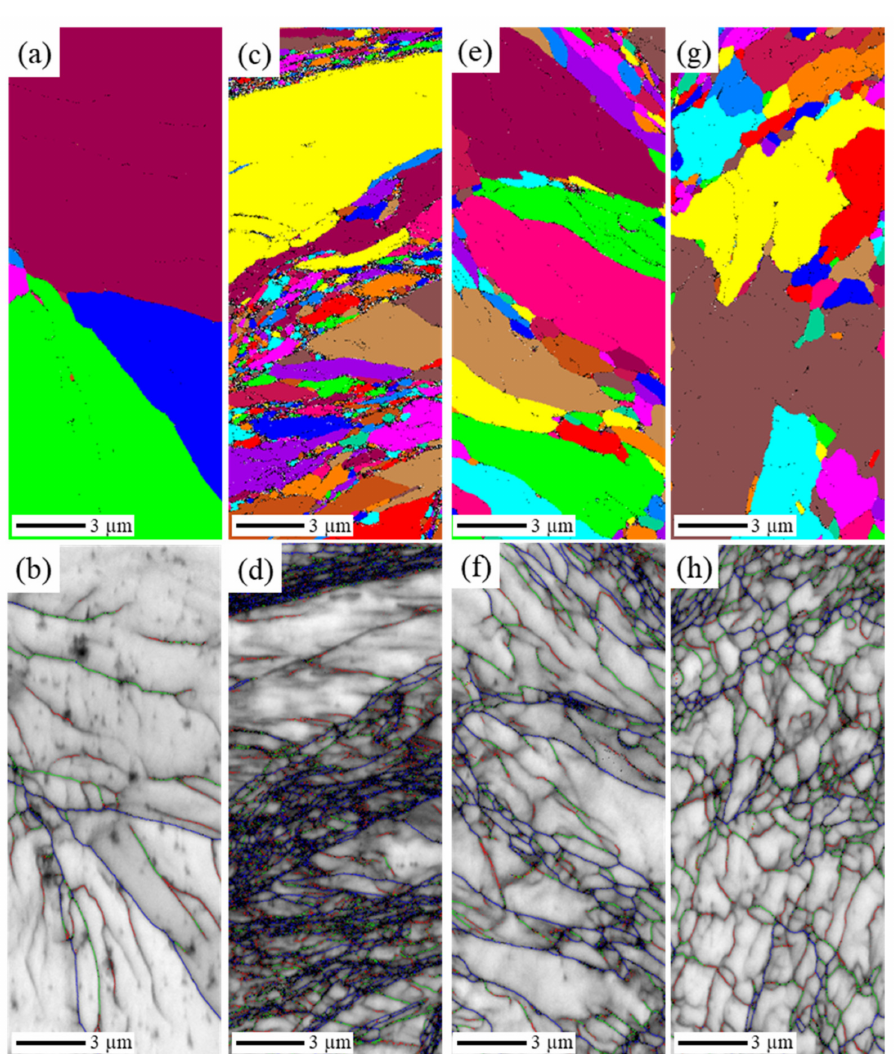
Figure 8. EBSD images depicting grain distributions before 1st heat treatment, measured from ( a , b ) as-received NbTi billet, ( c , d ) the ECAPed specimen with a strain of 2.0, ( e , f ) hot rolled specimen with a strain of 0.7 and ( g , h ) hot rolled specimen with a strain of 2.0. Red, green, and blue grain boundaries indicate the misorientation angle of 2–5 ◦ , 5–15 ◦ and over 15 ◦ , respectively. The microstructure evolution before and after the first heat treatment can be clearly confirmed in Figure 10. In the case of the ECAPed specimen, the number of β -NbTi grains with a size of 0.25 µ m decreased from 940 to 158 after first heat treatment. On the other hand, the number of β -NbTi grains with a size of 0.25 µ m in the hot rolled specimen with a strain of 2.0 tended to increase from 83 to 419 after first heat treatment. This supports the above results that each initial process condition has a great influence on recrystallization